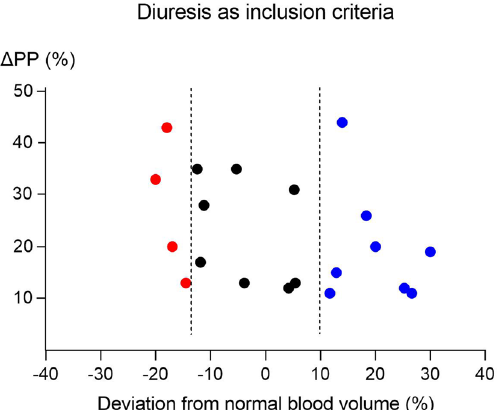
Fig. 7 Change in pulse pressure (ΔPP) following a passive leg raising test in relation to blood volume, in patients included due to diuresis < 0.05 ml/kg/h. No significant correlation could be found. r CI 0.562–0.485), p 0.85, Spearman correlation coefficient). Dotted lines illustrate limits of euvolemia − =